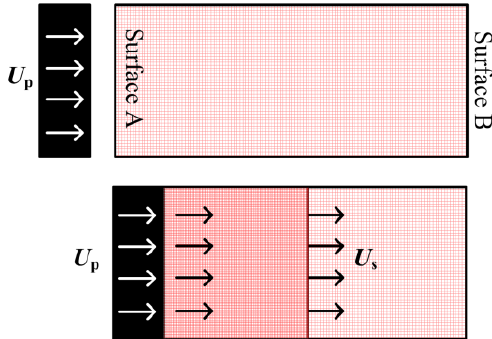
Figure 3. Schematic representation of shock-wave propagation.